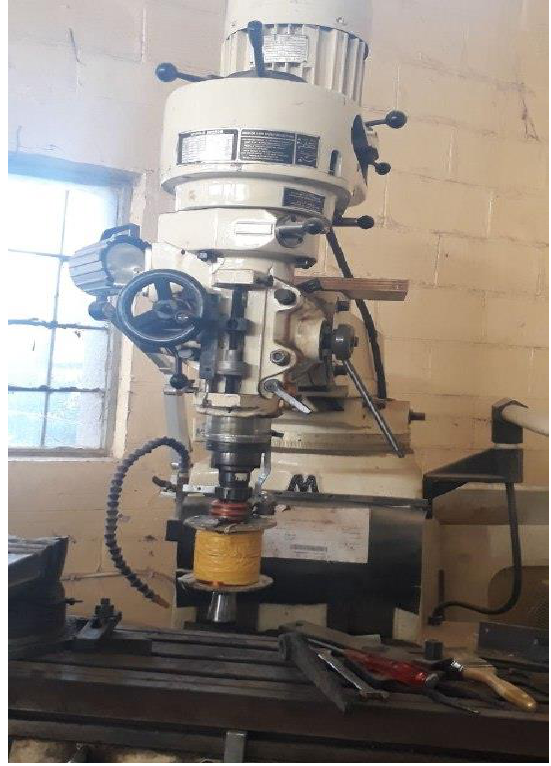
Fig. 4. MAF unit assembled on milling machine.